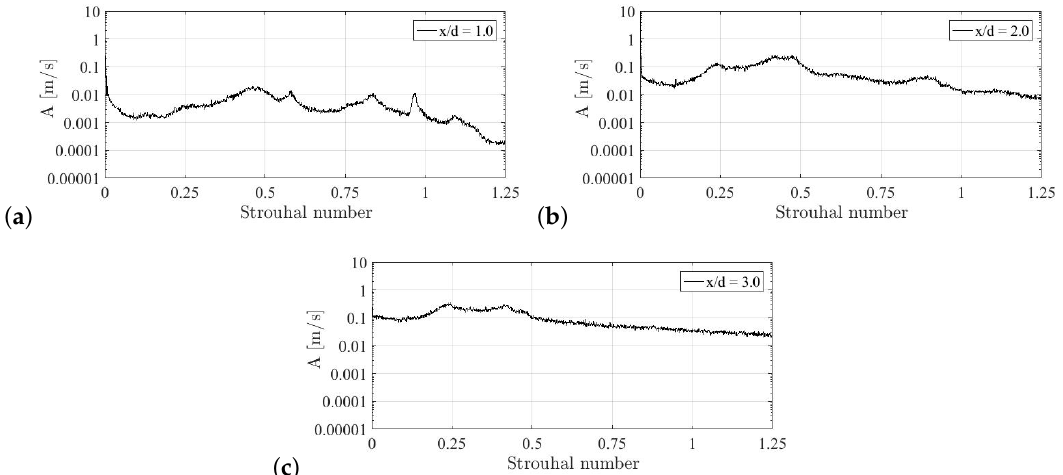
Figure 16. Evolution of spectra of axial velocity fluctuations, S = 0.5, L / D = 1, Re =